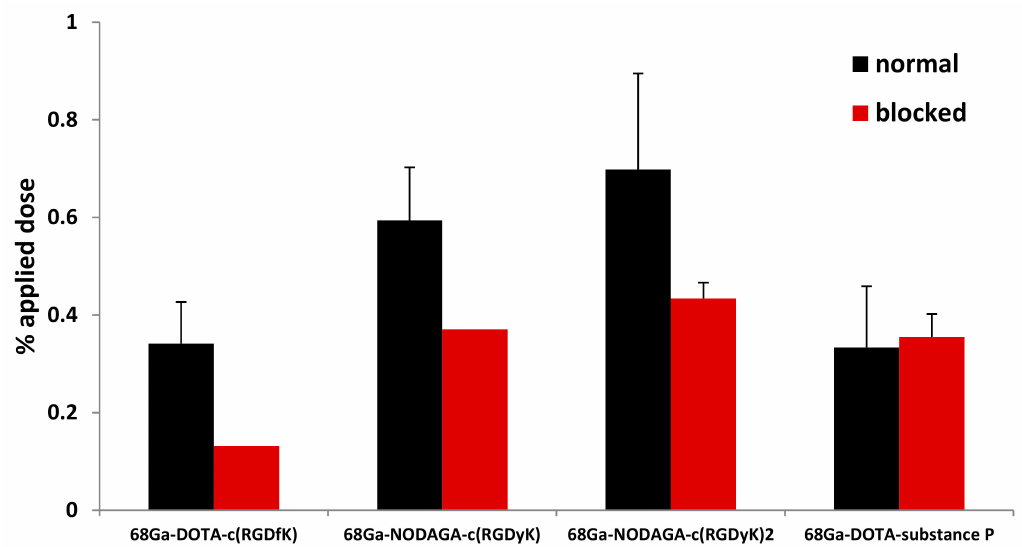
Figure 1. Accumulation of labeled peptides in normal U-87 MG cells (black bars) and U-87 MG cells blocked with an excess of appropriate “cold” RGD peptide (red bars). Data are presented as the mean of the percentage of applied dose ± standard deviation (n =